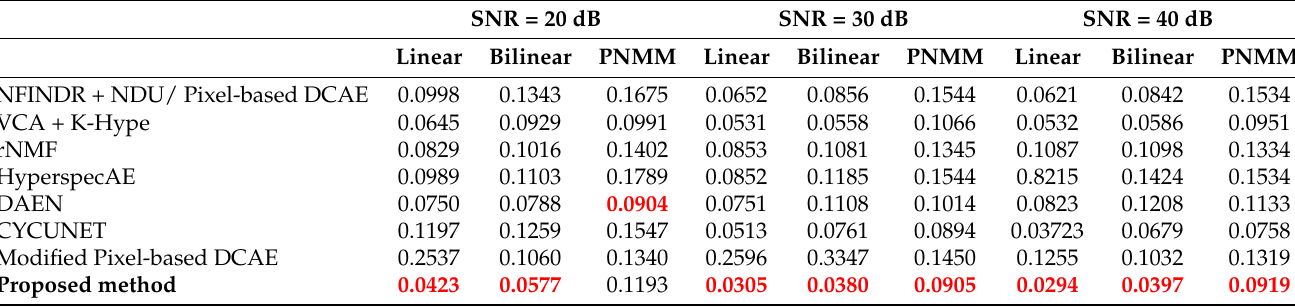
Table 4. Endmember SAD comparison of the synthetic data (best results are highlighted in